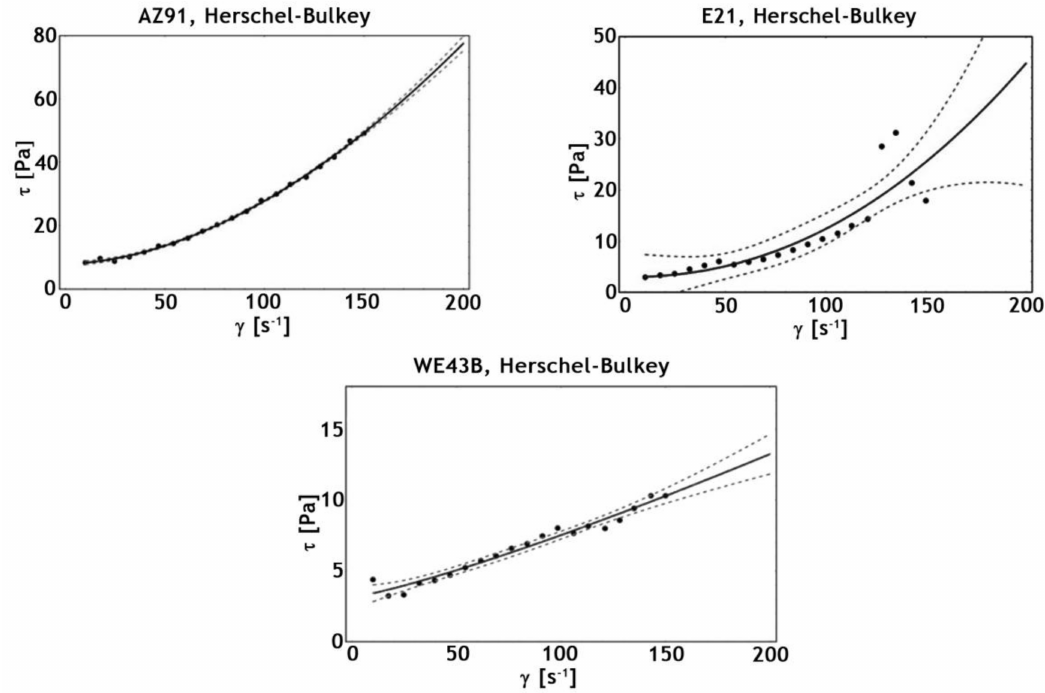
Figure 8. Approximated flow curves, along with mean prediction bands (functions of the predictor variables) calculated for the Herschel-Bulkley models, for each of the tested alloys: AZ91, E21 and WE43B (black continuous line—flow curve, grey dotted line—mean prediction